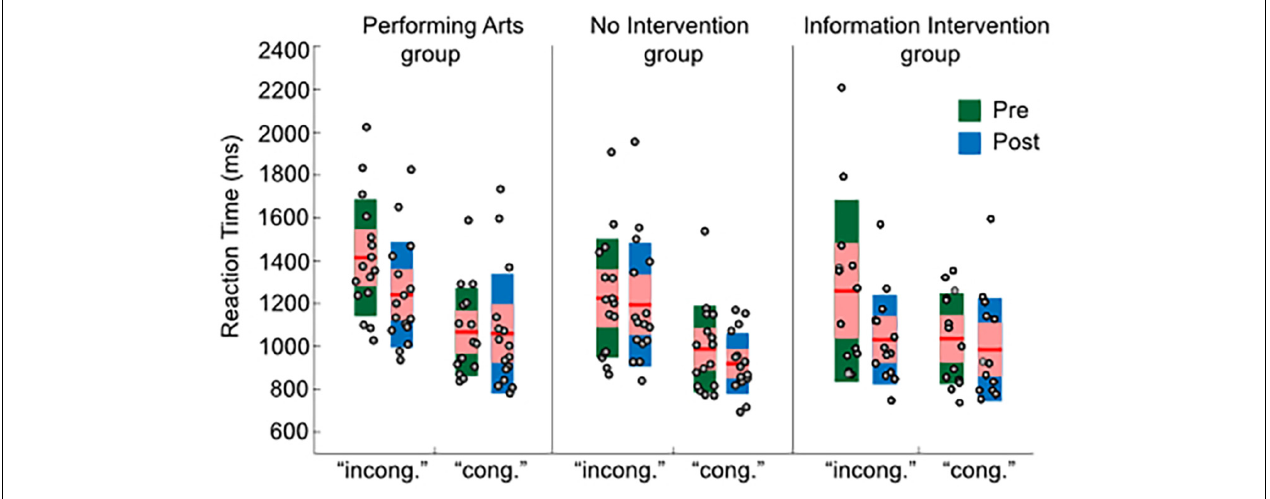
FIGURE 1 | Latency results for each study group and condition. RT measures were extracted by averaging RTs to associative blocks in the IAT design. The RTs for each individual and individual and condition are represented in gray circles. For all boxplots, the central mark is the median, the edges of the box are the 25 th and 75 th